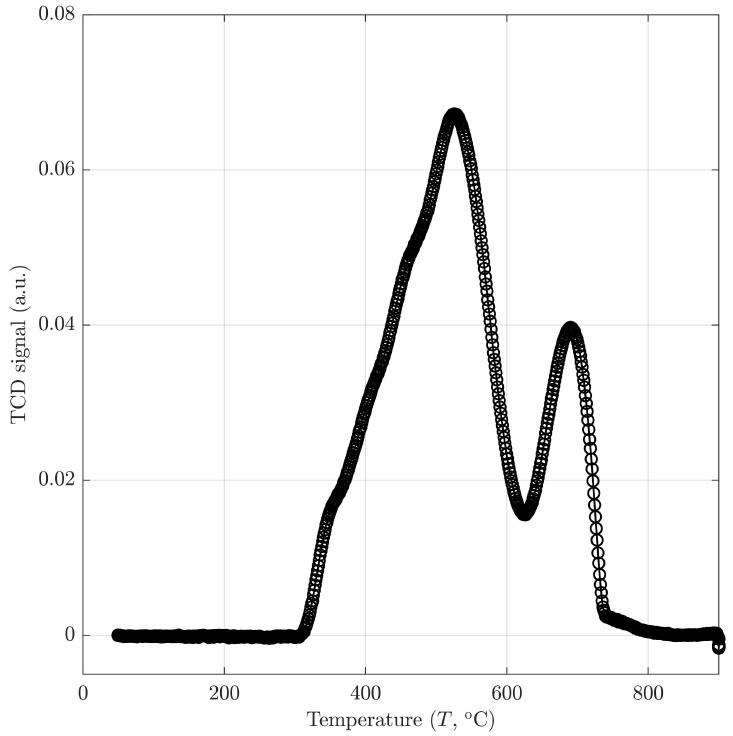
Figure 2. Temperature-programmed reduction results of GMC-Y3 and commercial catalysts.